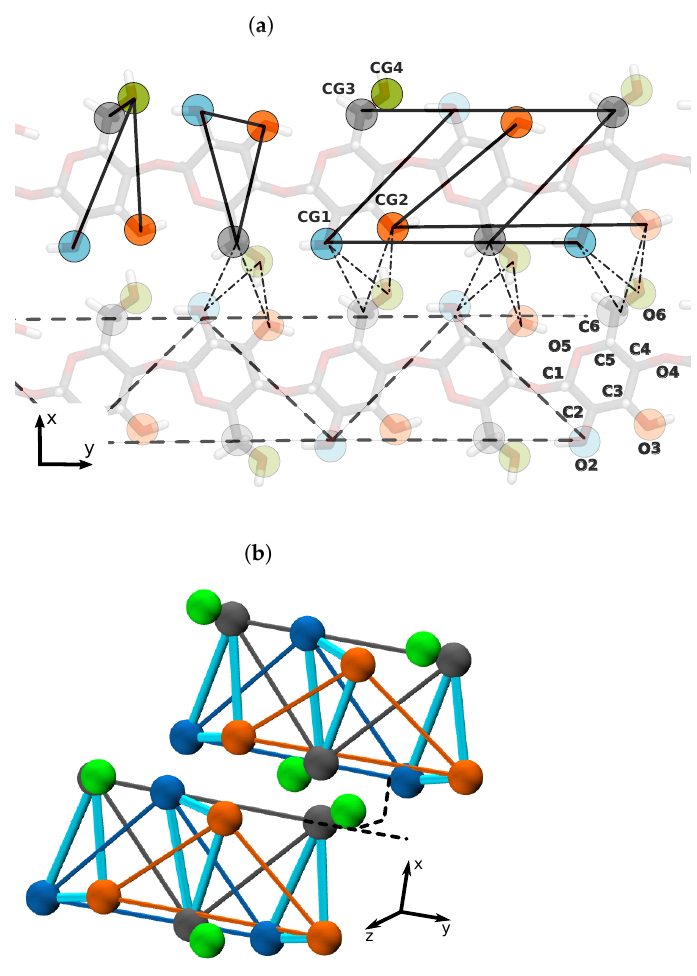
Figure 2. ( a ) Cellulose sheet representation of the CG model for the cellulose fibrils. Mapping of the atom, O2, O3, C6, and O6 into CG beads, CG1, CG2, CG3, and CG4, respectively, (top panel). Names of the heavy atoms in D-glucose are shown on the lower right. Solid lines indicate the bonded interactions of the model, dashed lines show the plane triangulation of a single cellulose chain, and thin dashed lines represent the non-bonded interaction between two parallel chains. ( b ) Equilibrated snapshot of two CG cellulose chains from two cellulose sheets for the I α allomorph. The intra-residue bonds are depicted using cyan and inter-residue bonds by grey and